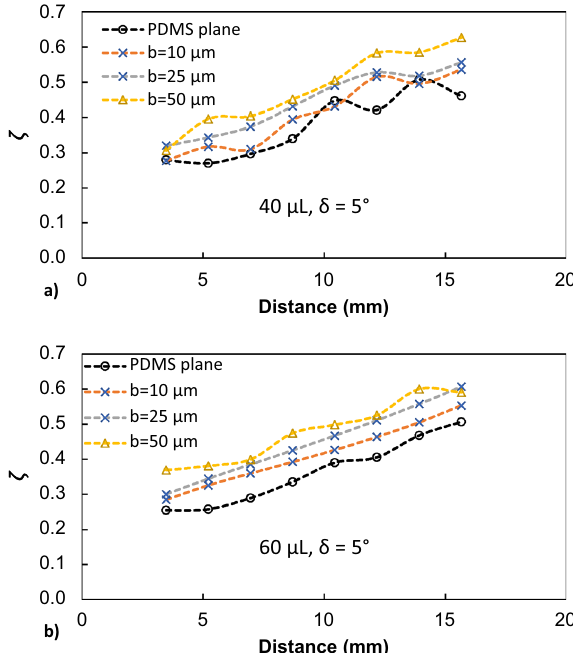
Figure 12. Droplet kinetic energy loss ratio ( ζ ) for various micro-post gap